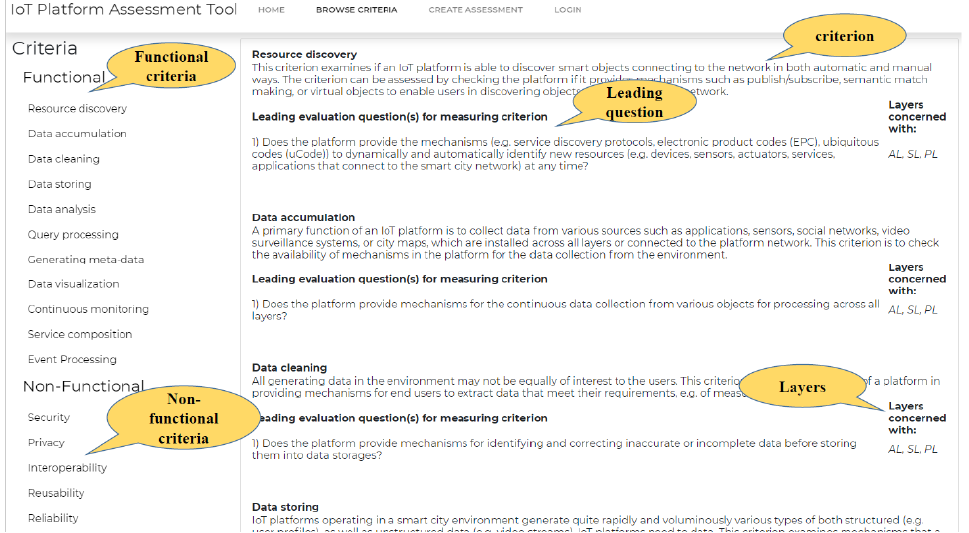
Figure 3. The main page of the IoT-PA, an implementation of the evaluation